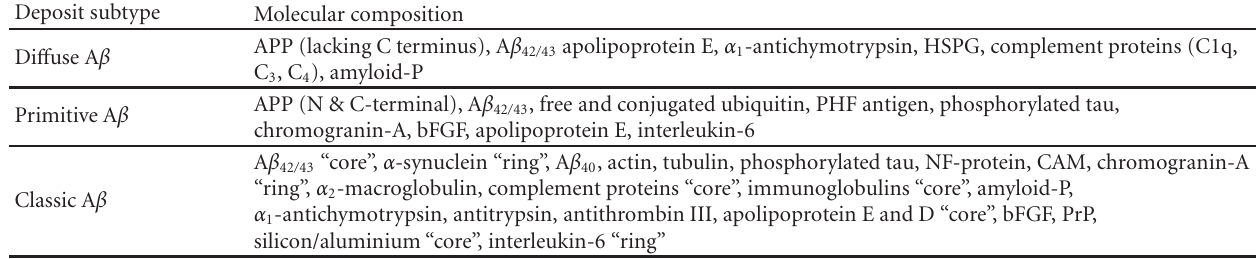
Table 1: Molecular composition of β -amyloid (A β ) deposits in Alzheimer’s disease